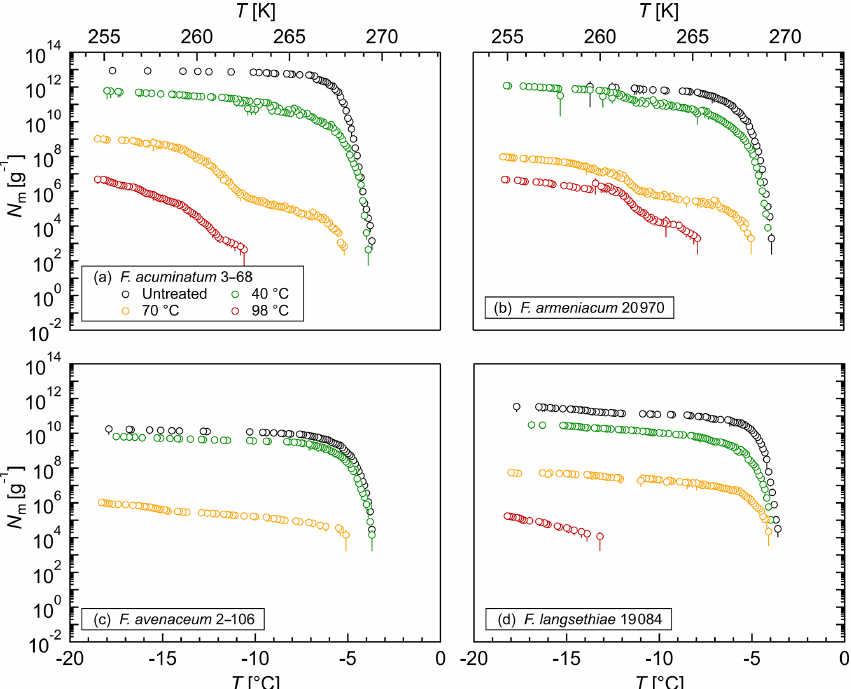
Figure 4. Effects of high temperatures on the ice nucleation activity of Fusarium : cumulative number of IN ( N m ) per gram of mycelium plotted against the temperature ( T ) for (a) F. acuminatum 3–68, (b) F. armeniacum 20970, (c) F. avenaceum 2–106, and (d) F. langsethiae 19084. The error bars were calculated using the counting error and the Gaussian error propagation.